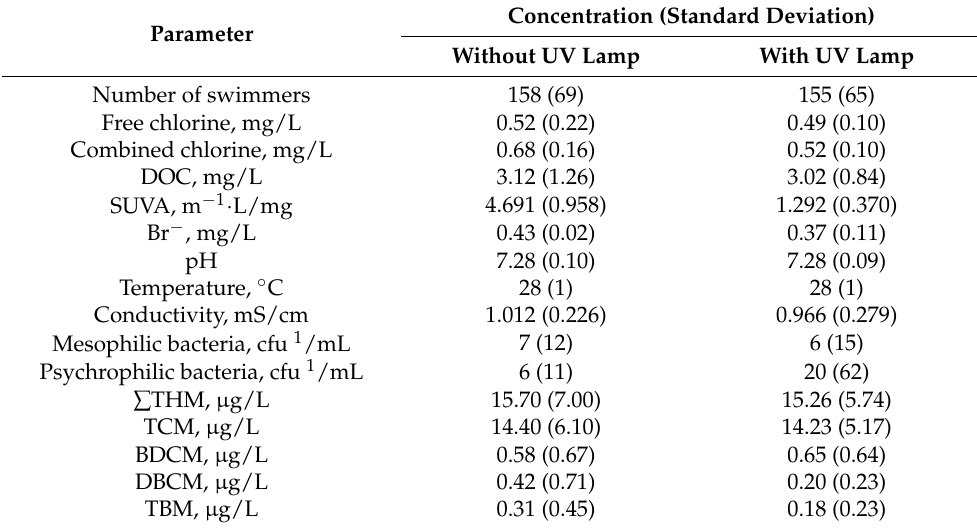
Table 1. Average values of swimming pool water quality parameters during water treatment with and without a UV